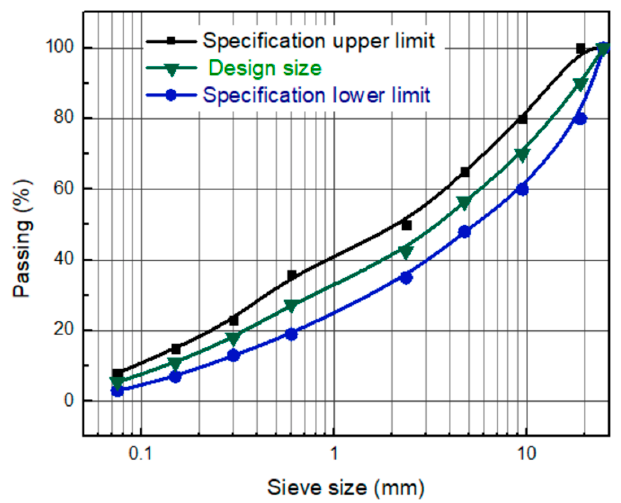
Figure 3. Aggregate gradation of the mix design.